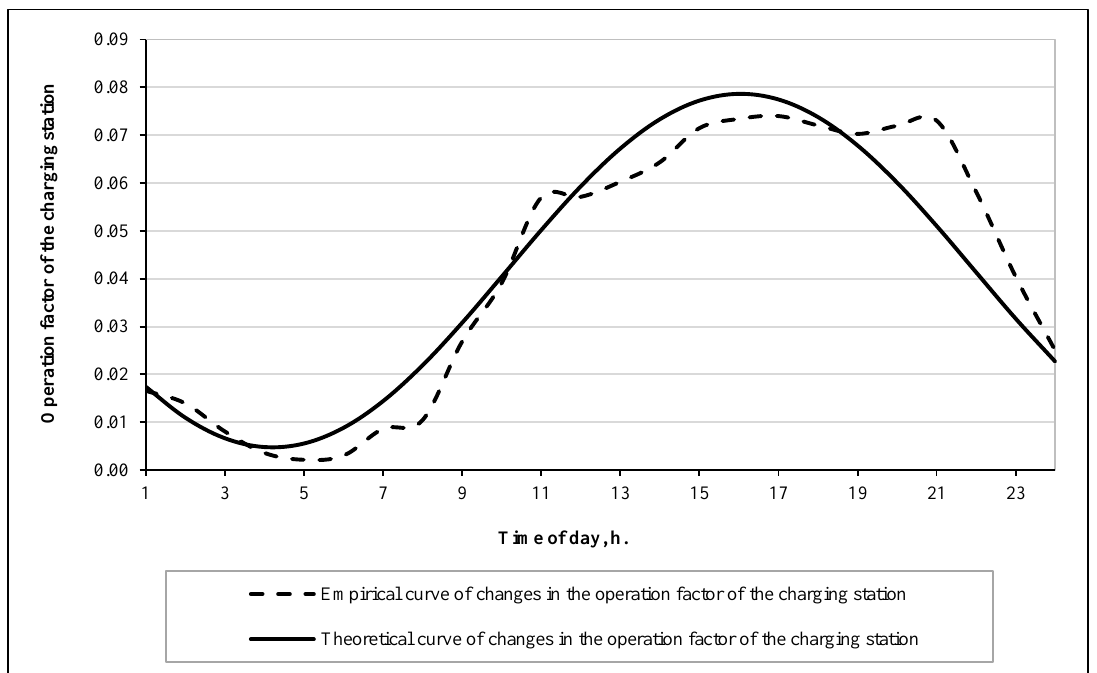
Figure 4. Curves of changes in the operation factor of charging stations during the day.